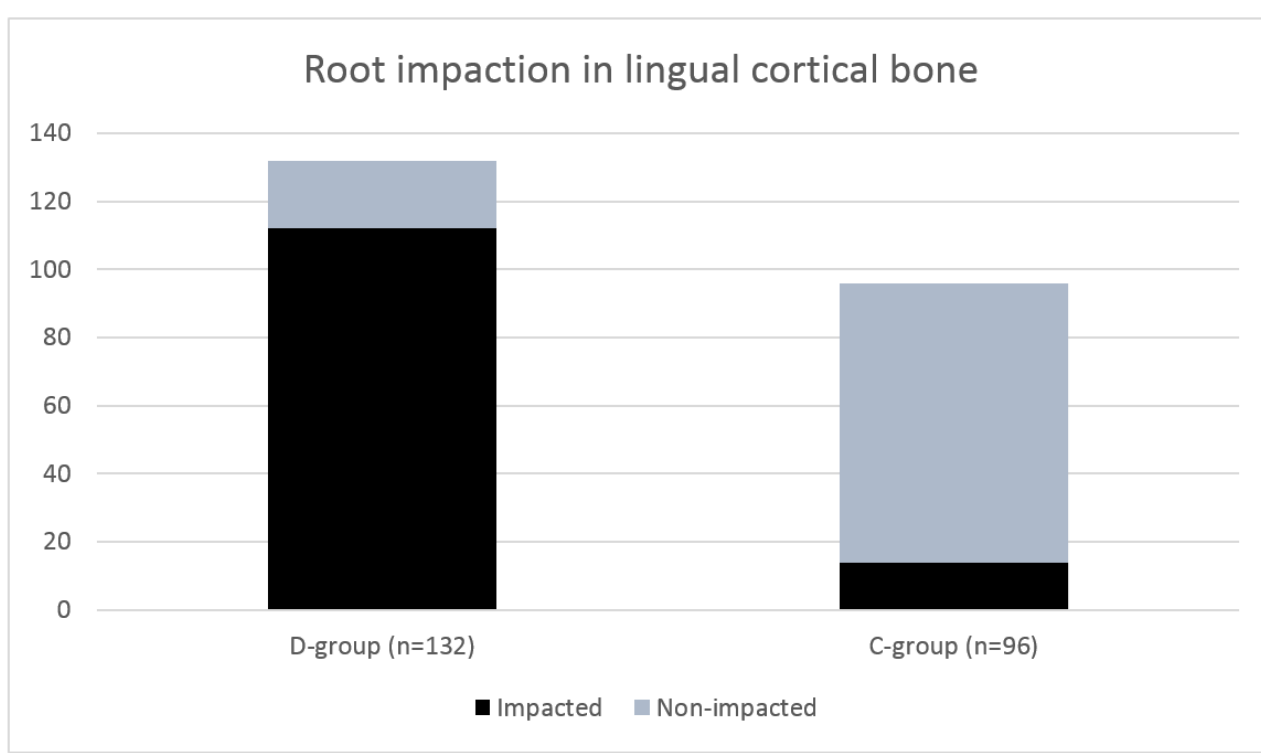
Figure 2. A graphic representation of the distribution of patients with impaction of the root in the lingual cortical bone of at least 1 mm (in black) in D-group (84.85%, 112/132) and C-group (14.58%, 14/96). Table 2. Mean distance across the study groups. SD = standard deviation, Sig = statistical significance using One-way ANOVA and T-test. *= p value with significance